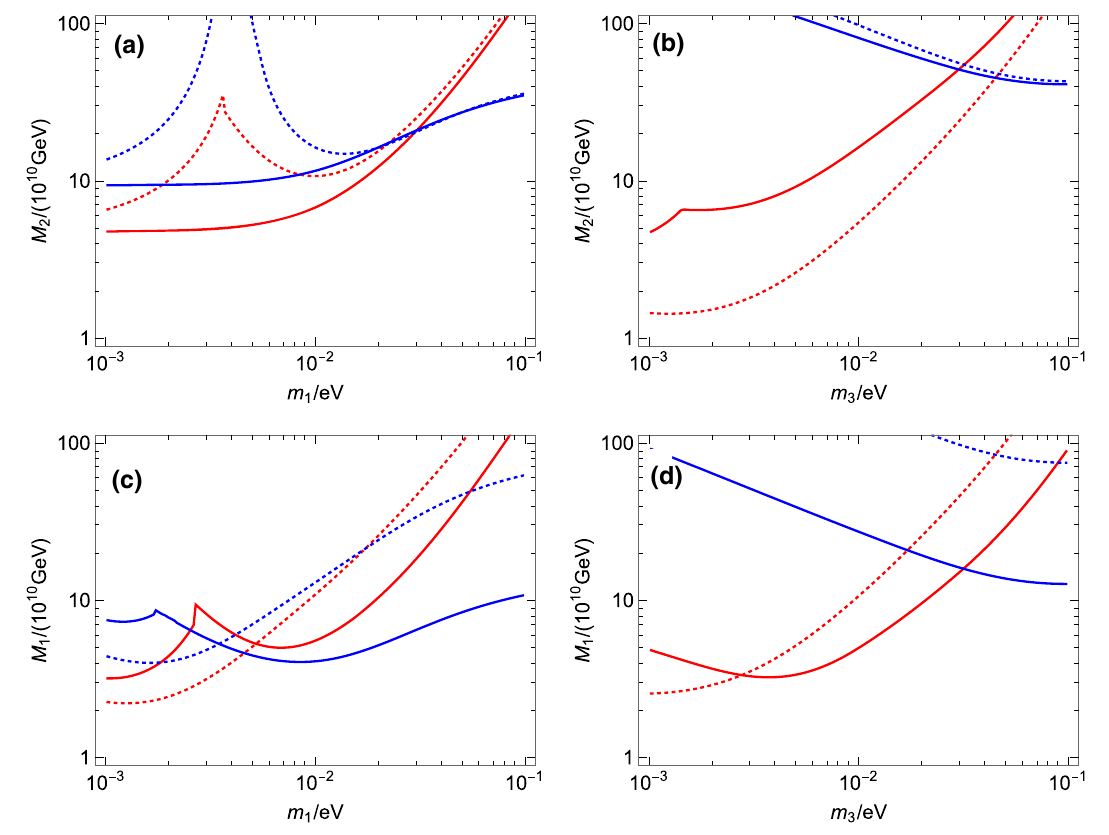
scenario, the lower bound on M tions of the lightest neutrino mass in the NO ( c ) and IO ( d ) cases. The red and blue solid (dotted) lines respectively correspond to η − 1 in the case of M